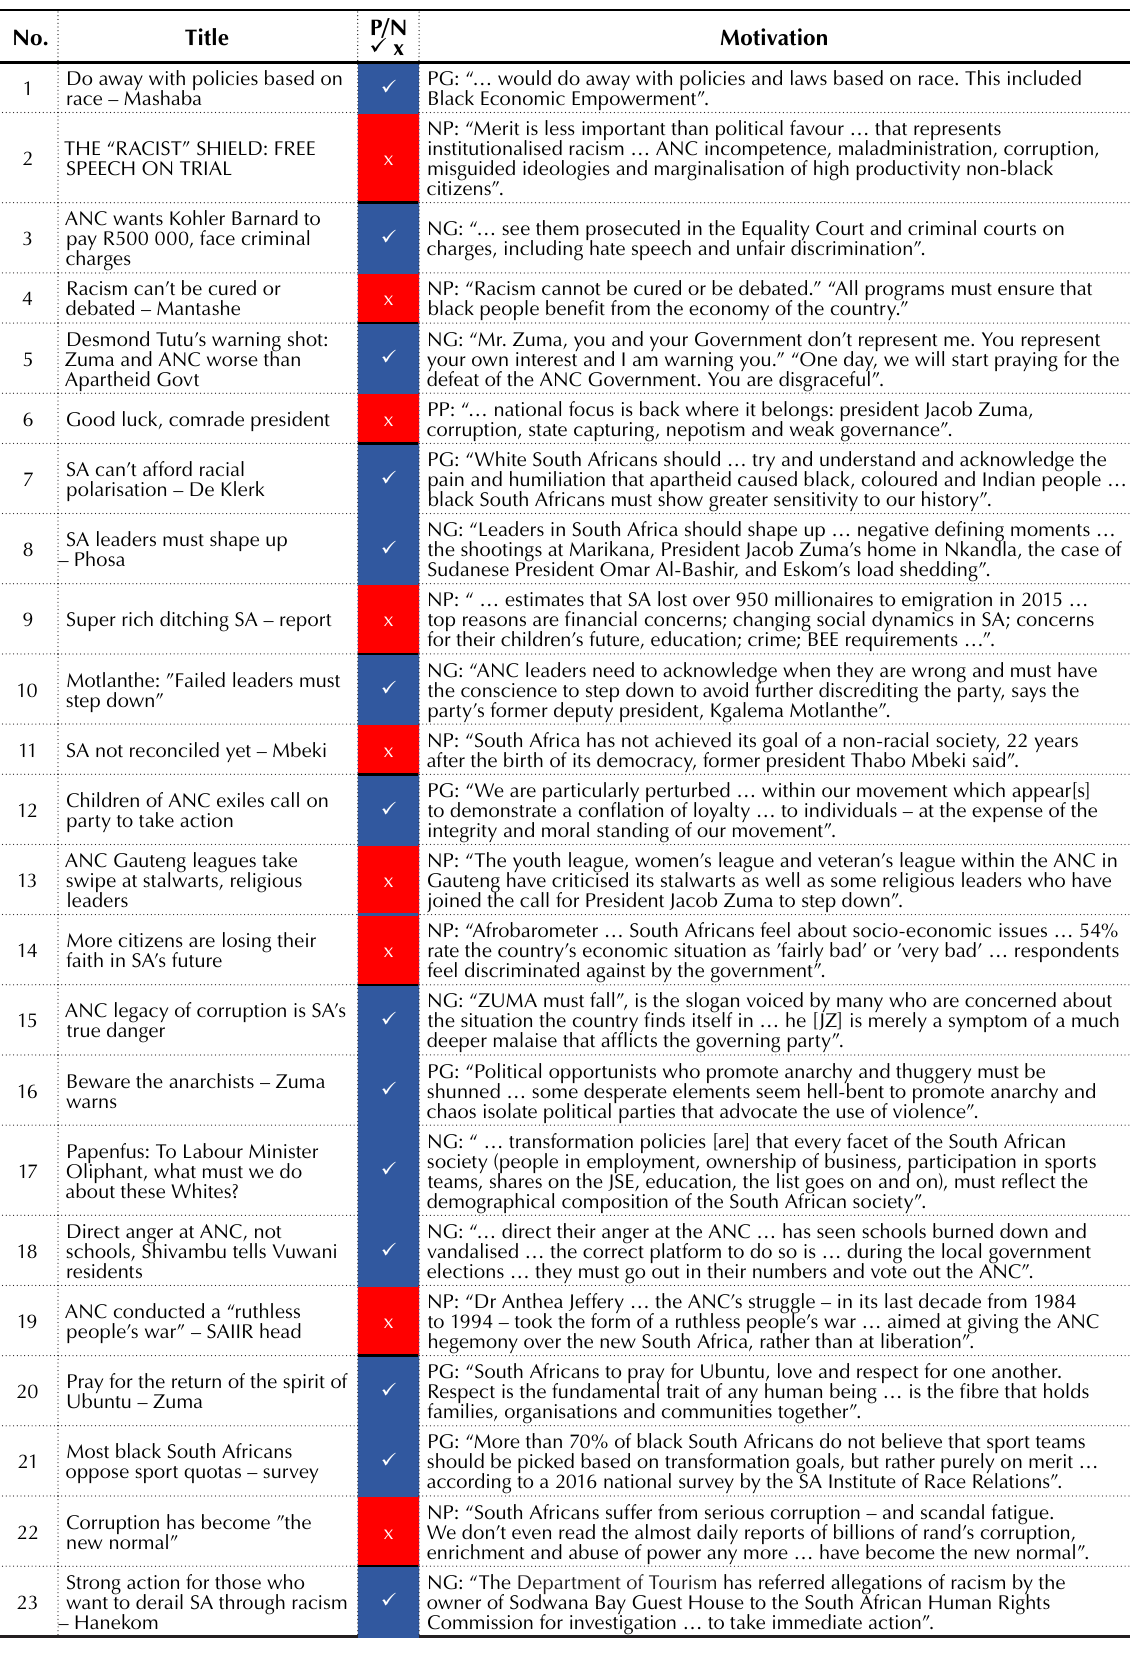
Table 3A. Social-cultural macro-environment (January-June 2016) P/N No. Title  x